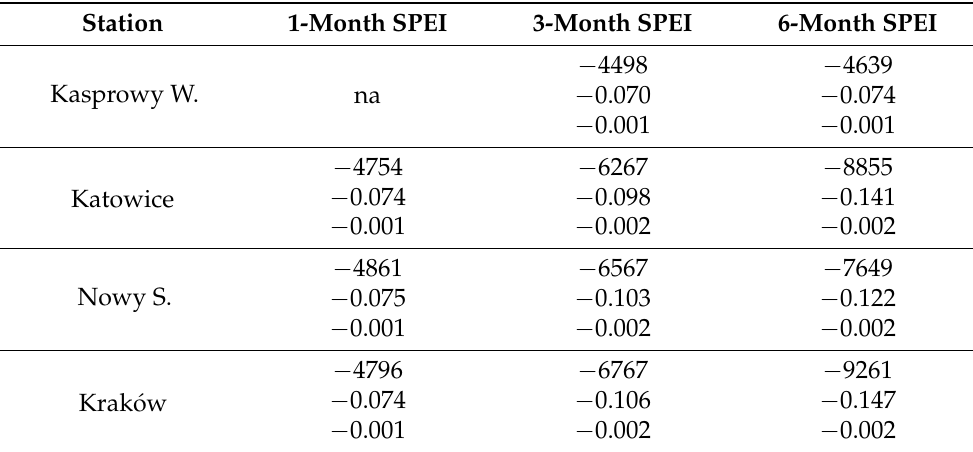
Table A3. Values of test statistics S (upper value), tau (middle value) and Sen’s slope (bottom value) of the Mann-Kendall test for those series of SPEI for which p -value calculated was <0.05.